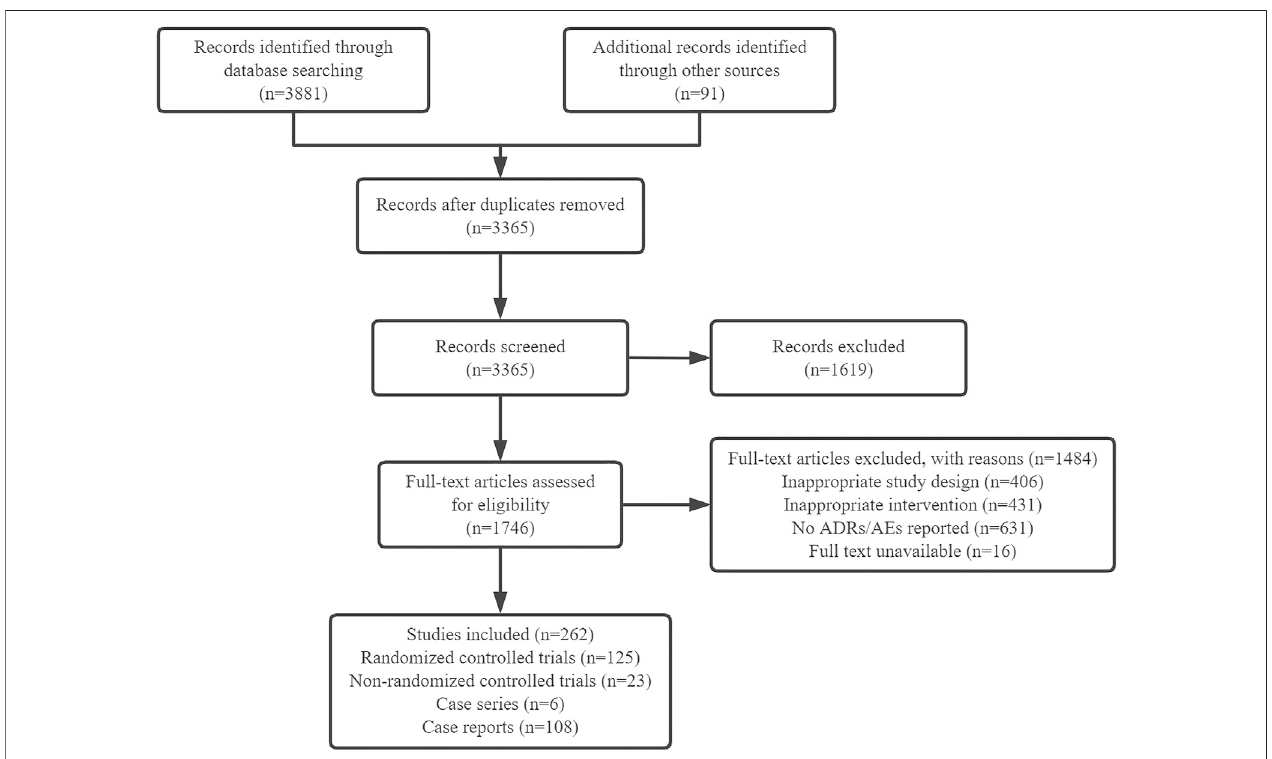
FIGURE 1 | Flow diagram of study